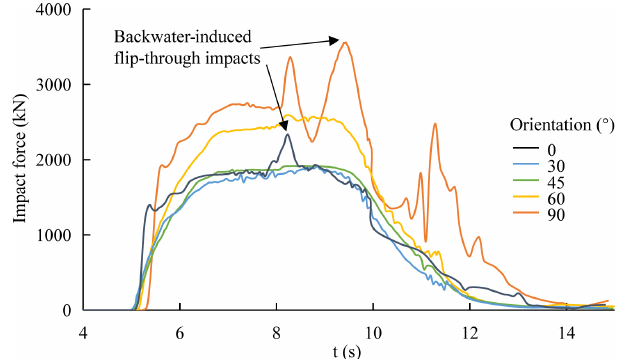
Figure 17. Impact forces time history with changing orientations in the scenarios of Orx-Op0- A null- D null after a simulation time of